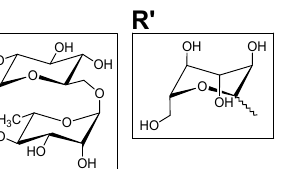
to form acid-stable, colored complexes with aluminum ions. (A) Chemical structure of rutin, where the